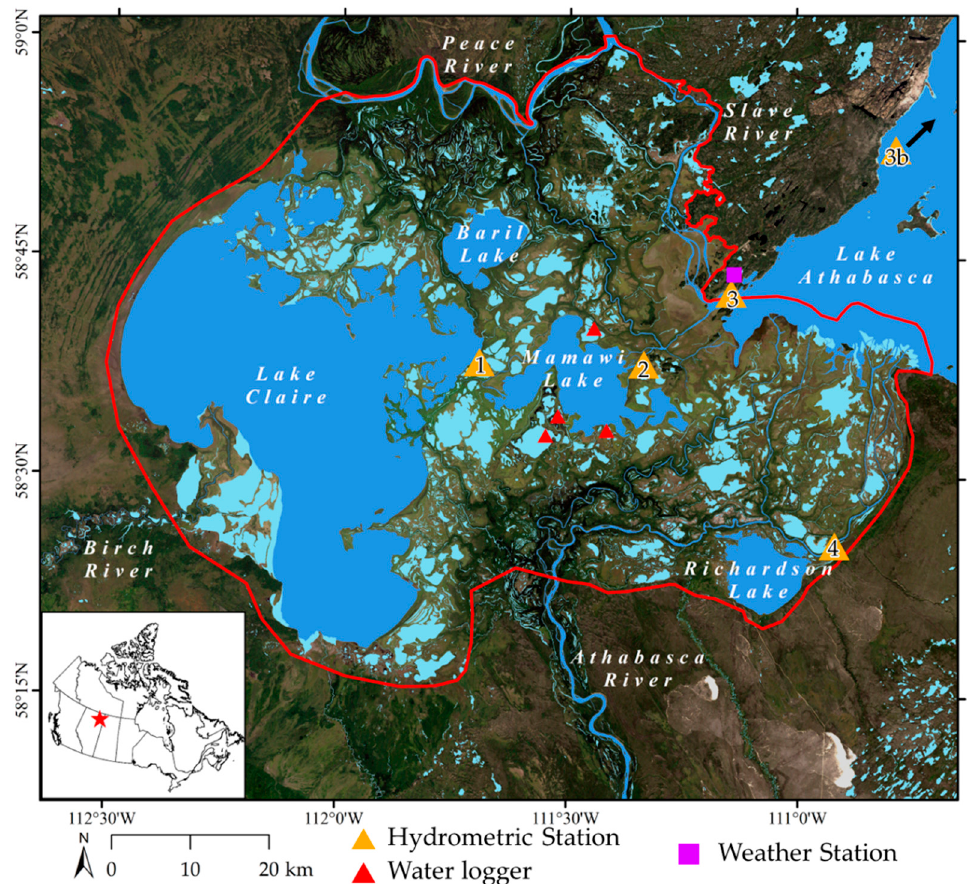
Figure 1. The red star shows the location of the study site in Canada. The red line shows the extent of the PAD. The darker blue highlights the major central lakes and rivers relevant to our study area. Light blue depicts water bodies recognized in the National Hydrographic Network of Canada map. Hydrometric stations highlighted are: 1—07KF002 Lake Claire near Outlet to Prairie River; 2—07KF003 Mamawi Lake Channel at Old Dog Camp; 3—07MD001 Lake Athabasca at Fort Chipewyan and 3b—07MC003 Lake Athabasca near Crackingstone Point; and 4—07DD007 Athabasca River above Jackfish Creek. Temporary water loggers and the local weather station are also shown as red triangle and purple square, respectively.